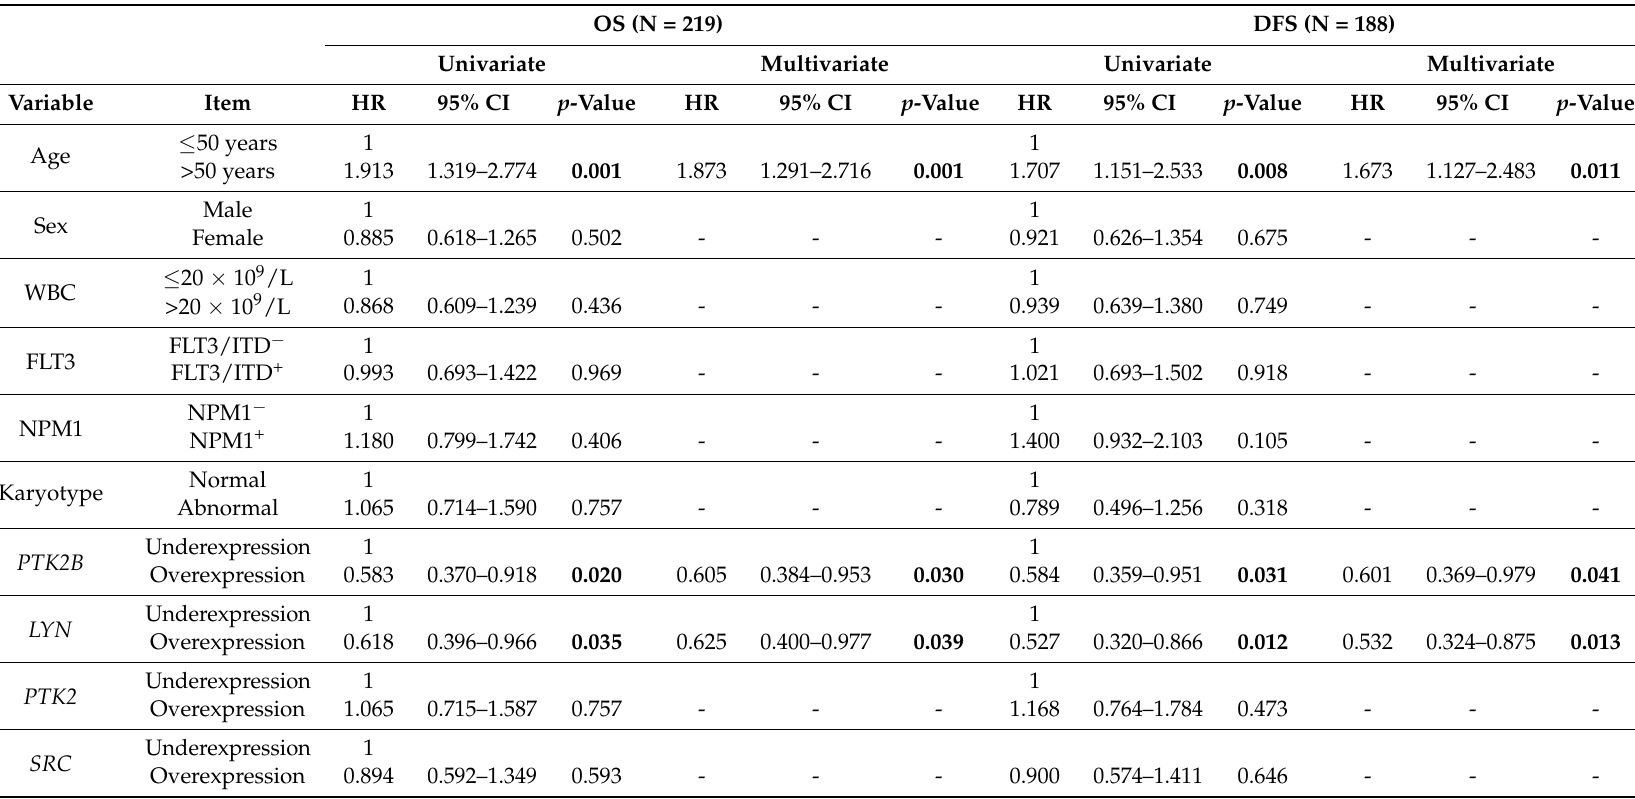
Table 4. Univariate and multivariate analyses of the association between relevant clinical variables and focal adhesion gene expression with OS and DFS in patients with non-favorable FLT3/NPM1 combinations with cytogenetic